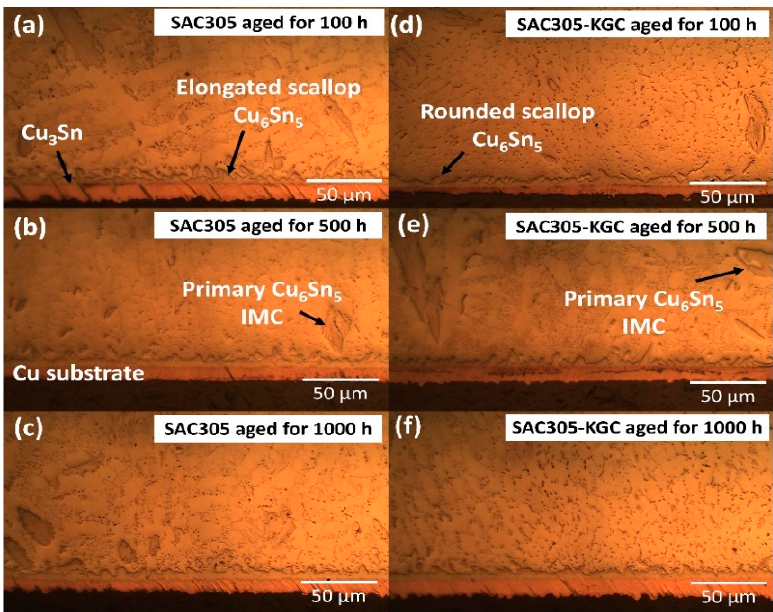
Figure 7. Interfacial IMC layer subjected to isothermal ageing at 85 °C. Non-reinforced SAC305 at